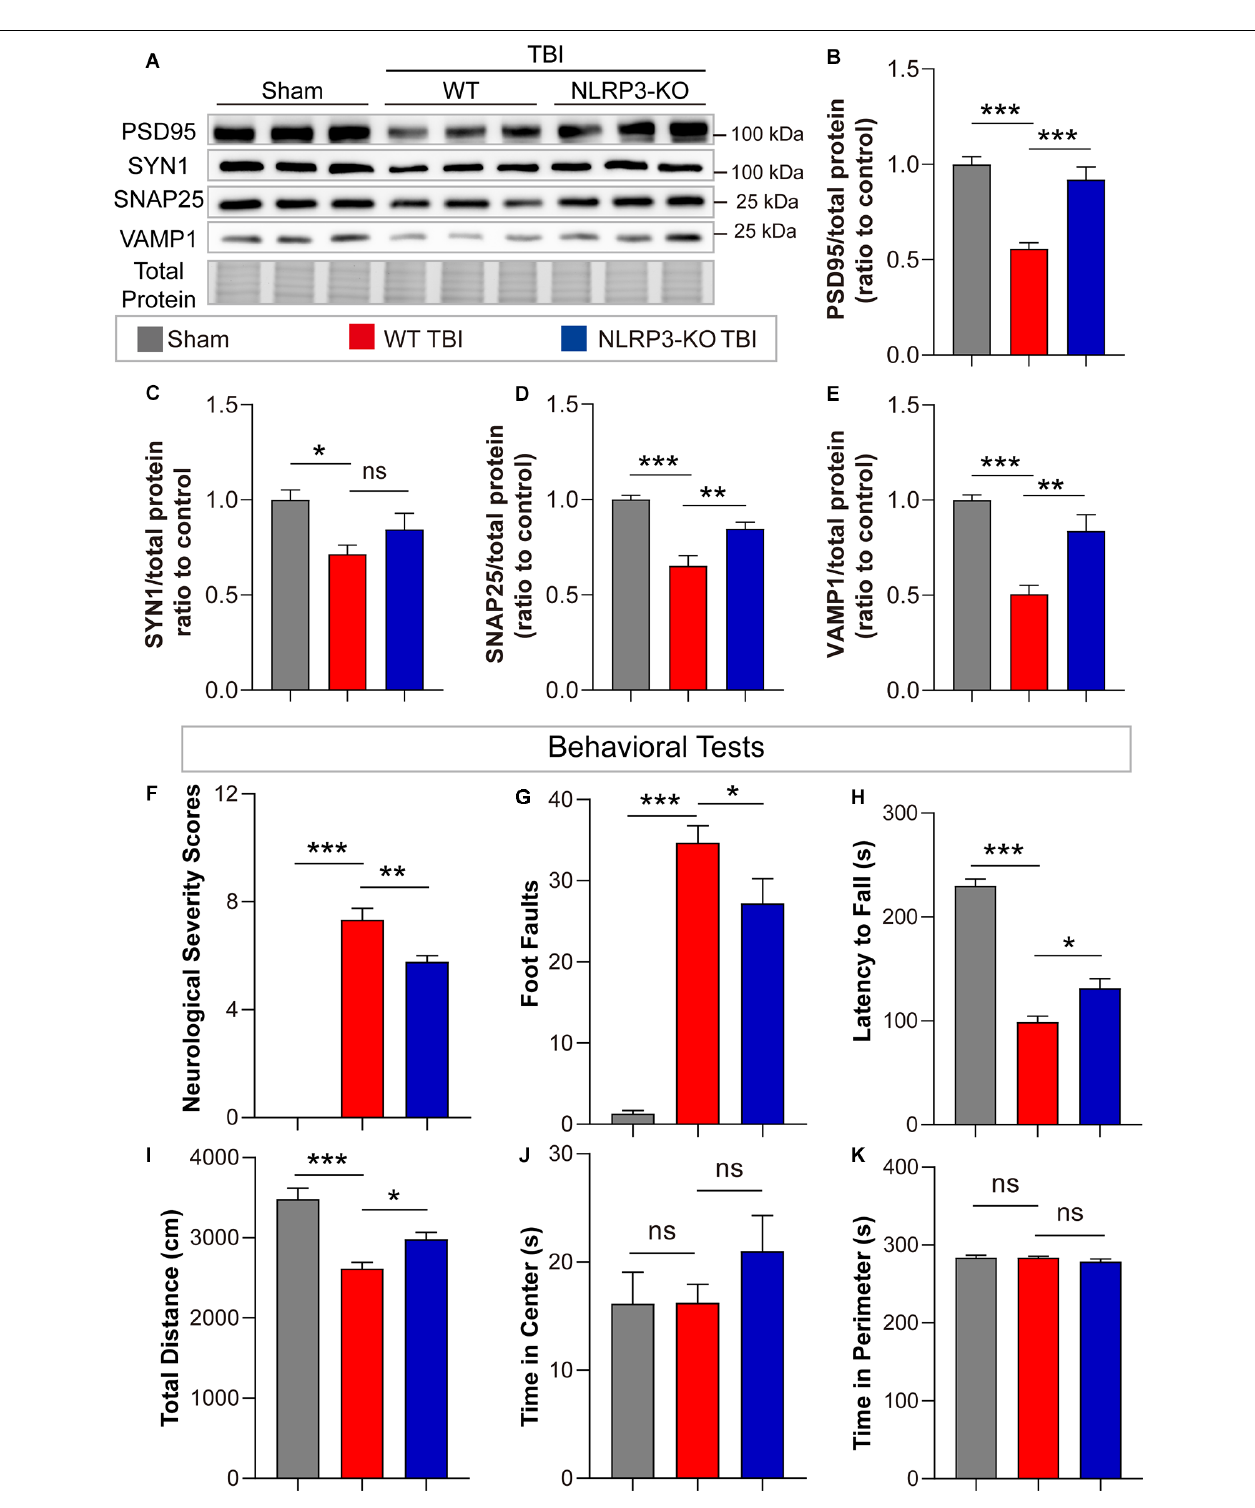
FIGURE 7 | NLRP3-KO attenuated synaptic protein loss and neurological deficits at 3 days after TBI. (A) Representative images of immunoblots for synaptic proteins (PSD95, SYN1, SNAP25, and VAMP1) and total protein. (B–E) Quantitative analysis of synaptic proteins ( n = 6). (F–H) Quantitative analysis of NSS scores, foot faults and latency to fall (s) from the NSS test, beam walk test, and accelerating rotarod test ( n = 9–10). (I–K) Quantitative analysis of total distance (cm), time in center (s) and time in perimeter (s) in the open field test ( n = 9–10). All data are presented as the mean ± SEM and were analyzed using one-way ANOVA followed by Tukey’s multiple comparisons test for significance. ns p > 0.05, * p < 0.05, ** p < 0.01, and *** p <